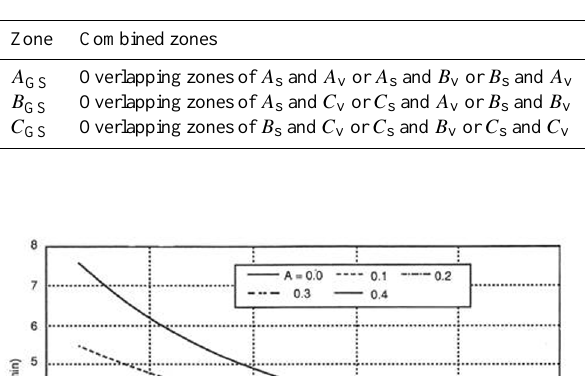
Table 3. The combination of zones used to produce the ground shaking zonation map (MERM, 2003).